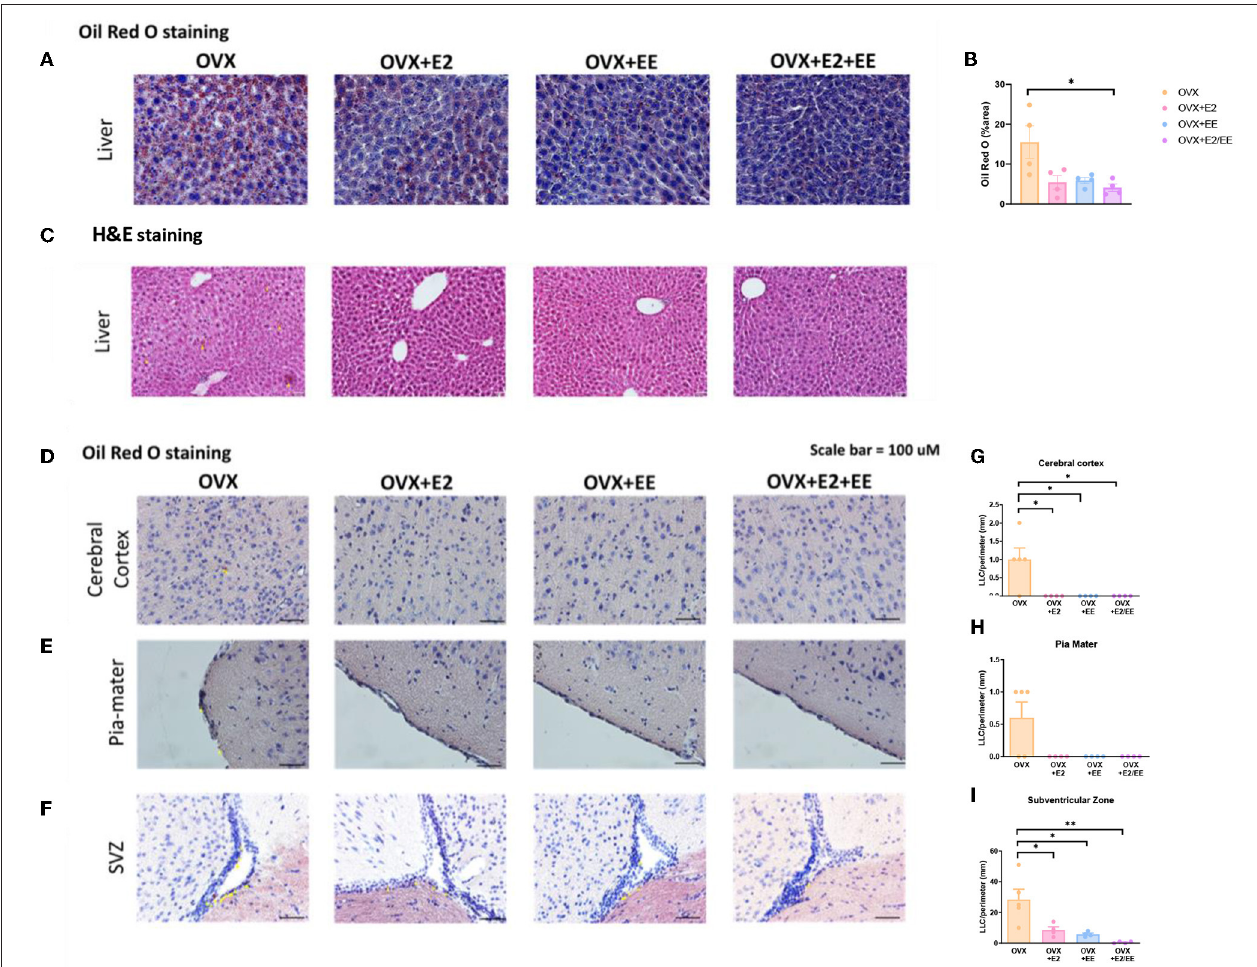
FIGURE 8 | Abnormal lipid accumulation was alleviated by exposure to EE and estrogen treatment in OVX mice. (A) The representative images of ORO-stained liver of the OVX groups, and (B) quantification thereof. (C) The representative images of H&E-stained liver of the OVX groups. The representative images of ORO-stained (D) cerebral cortex, (E) pia-mater, and (F) SVZ, and (G–I) quantification thereof, respectively ( n = 4 per group). One-way ANOVA with Tukey multiple comparison test. Data represented are means ± SEM. * p < 0.05 and ** p < 0.01. White bars = 50 µ m.